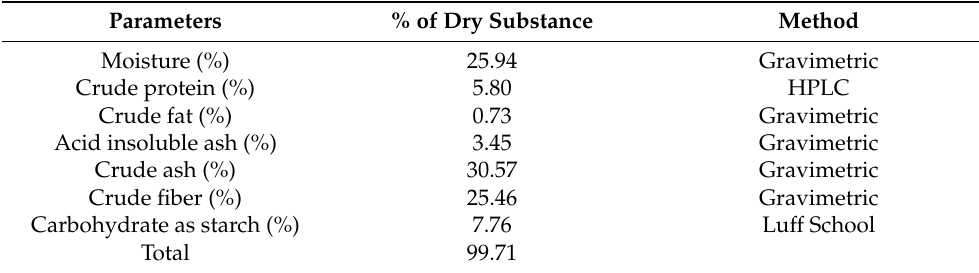
Table 1. Content of the fresh fungus combs from the M. gilvus